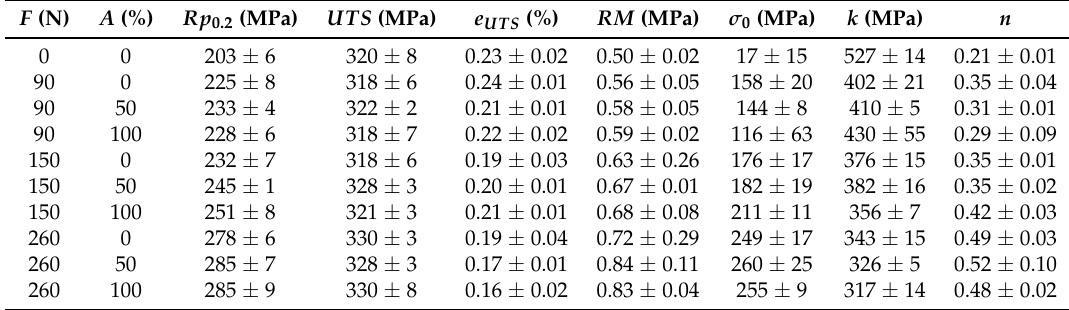
Table 5. Mechanical properties and their standard deviations calculated from the stress–strain curves.